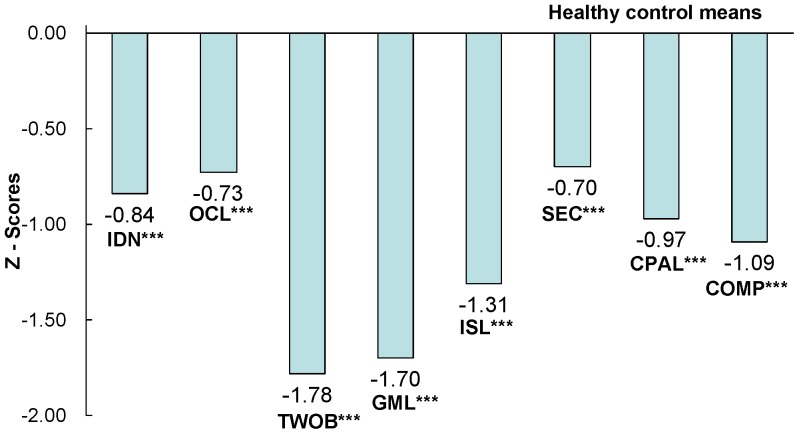
Magnitude of impairment relative to healthy controls in the CSB-C.Abbreviation: ISLT International Shopping List Task, DET Detection Task, IDN Identification Task, OCL One Card Learning Task, ONB One Back Task, CPAL Continuous Paired Association Task, GML Groton Maze Learning Task. Numbers of the figure are Z-score. **p<0.01, ***p<0.001.